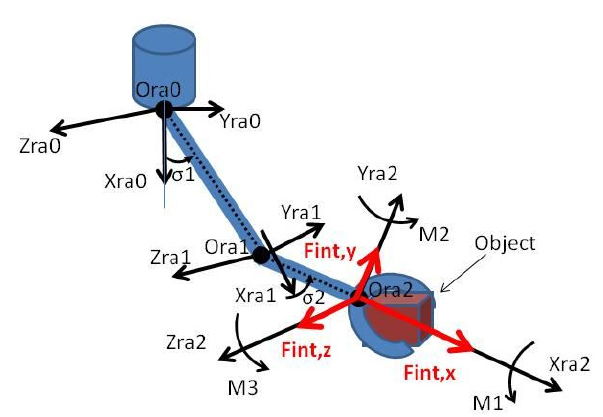
Figure 3. Generated forces and moments by the grasped object.